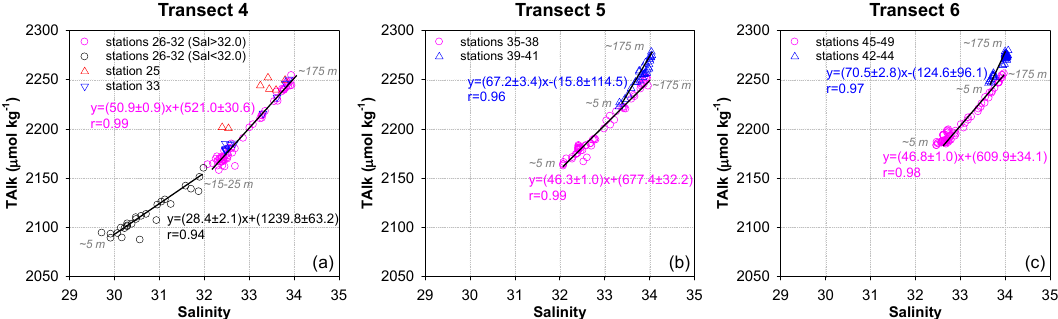
Figure 3. Total alkalinity versus salinity (TAlk–Sal relationship) in the upper 175m waters of sampling stations along transects 4 (a) , 5 (b) and 6 (c) off Oregon and northern California in spring/early summer 2007. The solid lines as well as the equations (in accordance with the symbol colors) indicate the linear regression analyses of the TAlk–Sal relationship for various stations. The numbers in italics denote the sampling depth/depth range of the endpoints of each line. In (a) , the TAlk–Sal relationship at station 26–32 displayed two phases for waters with salinities lower and higher than ∼ 32.0. The surface waters at these stations were imprinted by the Columbia River plume. The data points of bottom waters at stations 26 ( ∼ 75m) and 27 ( ∼ 130 and ∼ 160m) were not included, as they were located on the third linear relationship shown in Fig. 2a. In (b) and (c) , stations 39–41 and stations 42–44 were largely influenced by coastal